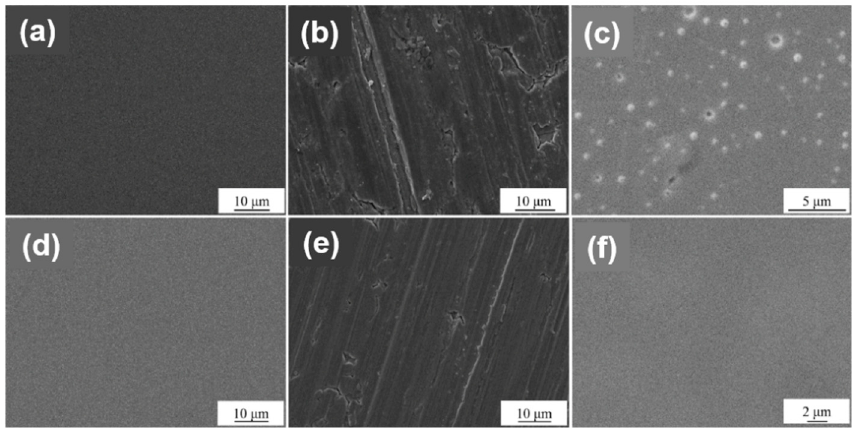
Figure 7. The SEM images of oxidized samples: TiN-1 ( a ), TiN-2 ( b ), TiN-3 ( c ), ZrN-1 ( d ), ZrN-2 ( e ), ZrN-3 ( f ).